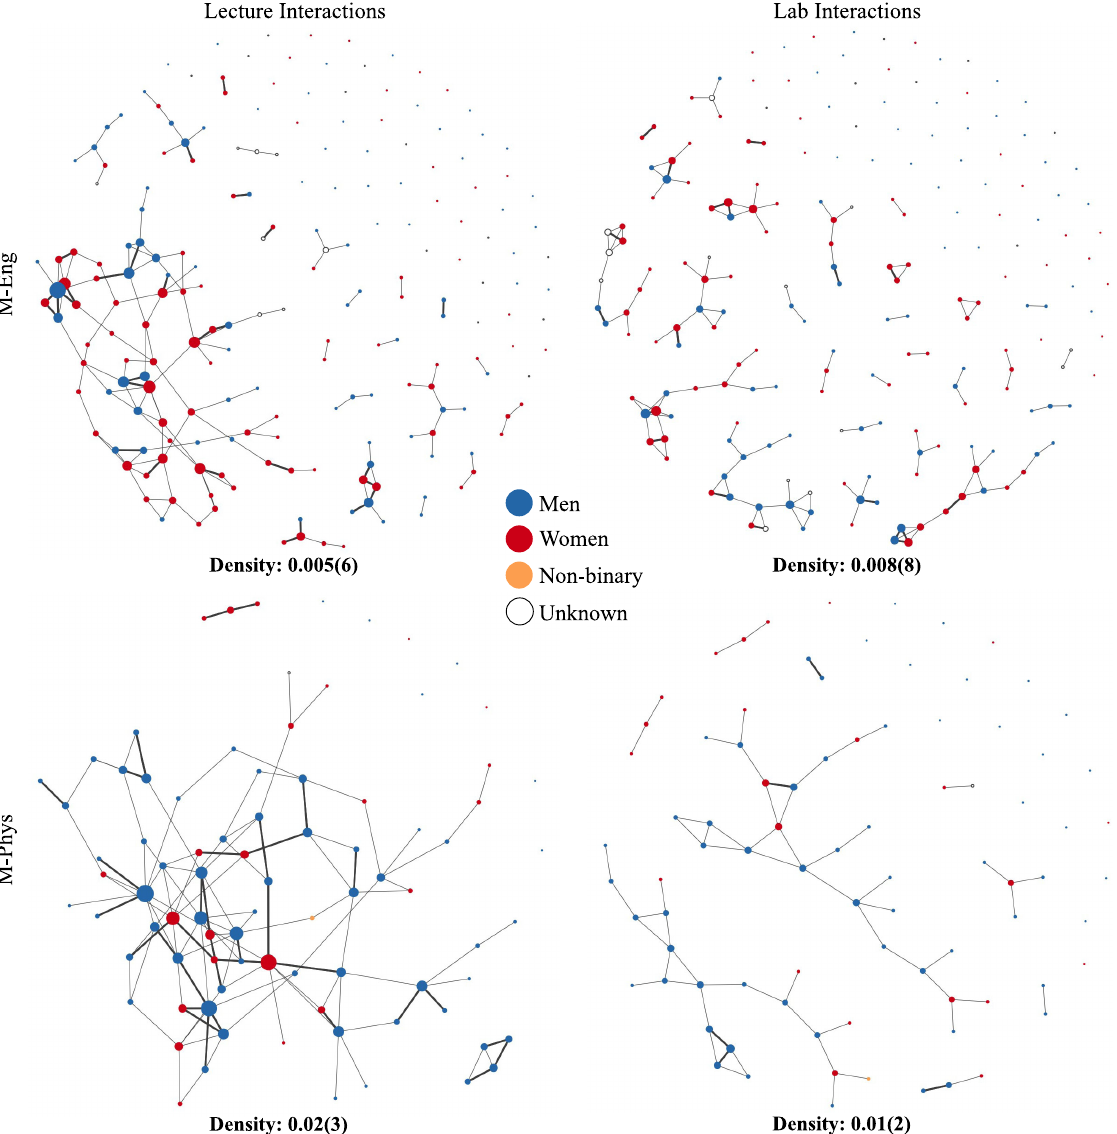
FIG. 2. Diagrams and densities of interaction networks for M-Eng and M-Phys. Nodes are colored by gender and sized proportional to total degree (number of adjacent edges). Thick edges represent reciprocal edges (students A and B both reported interacting with one another) and thin edges represent one-way edges (student A reported interacting with student B, but student B did not report interacting with student A). Densities are the proportion of observed to possible edges, with standard errors of the last digit shown in parentheses. These same network diagrams with nodes colored by race or ethnicity are in the Supplemental Material